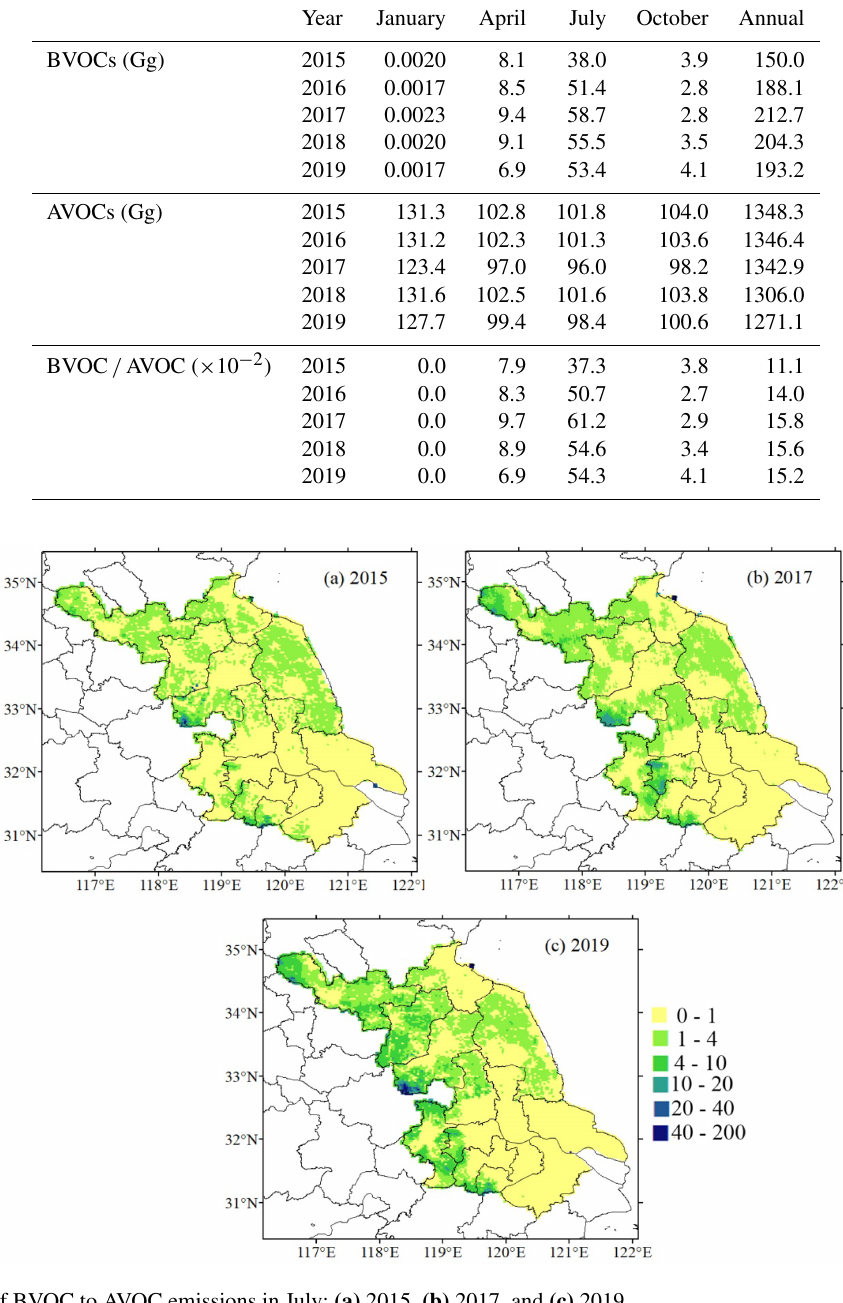
Figure 6. The ratios of BVOC to AVOC emissions in July: (a) 2015, (b) 2017, and (c)